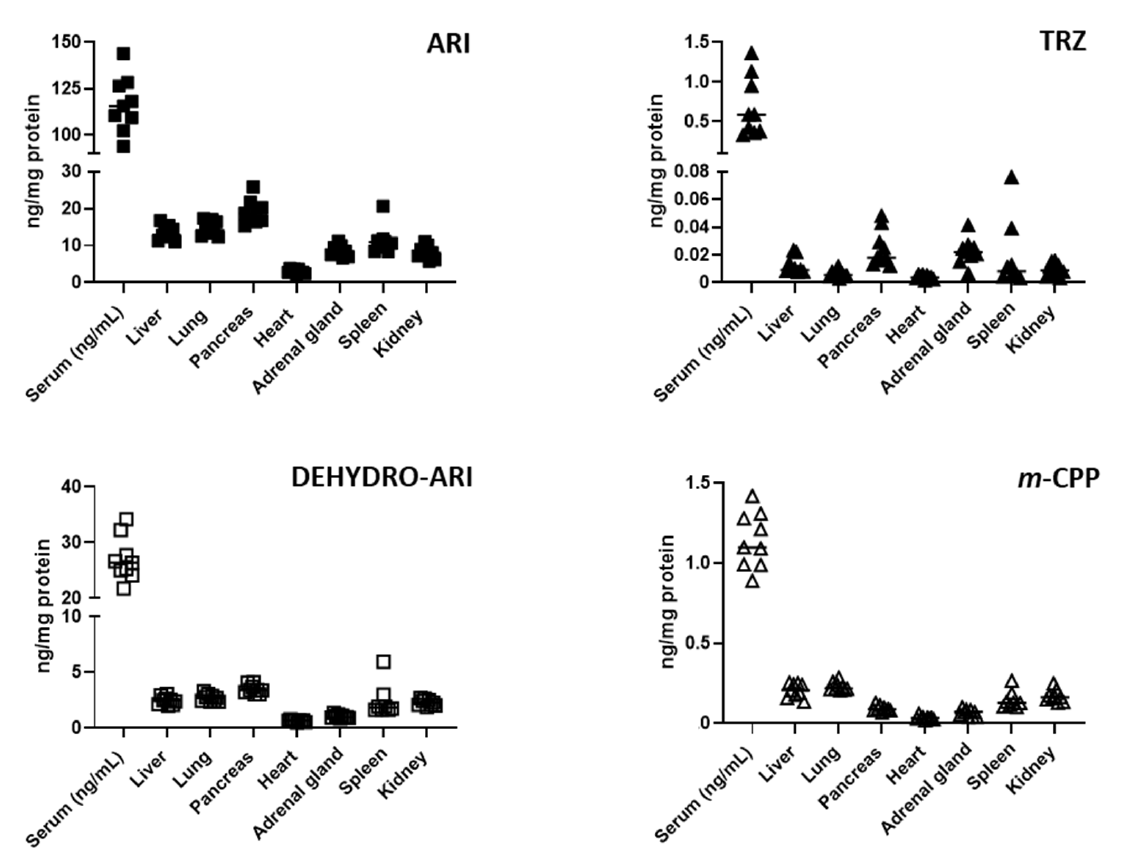
Figure 4. ARI and TRZ are detected in the serum and seven peripheral organs. Polypharmacy treatment ARI (2.5 mg/kg) + TRZ (10 mg/kg) data are reported. Symbols represents ARI, TRZ, or metabolite concentration in a single ARI + TRZ-treated sample. Both drugs and their metabolites were detected in serum and peripheral organs.